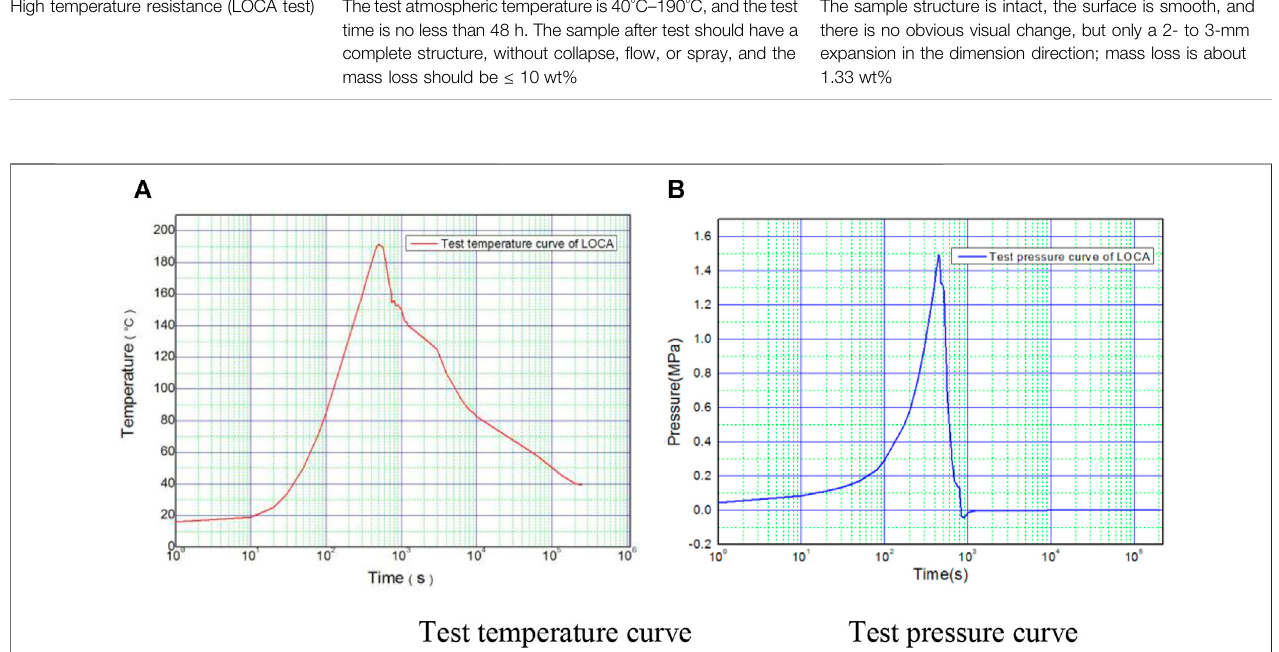
FIGURE 3 | Environmental condition test parameters of the simulated design basis